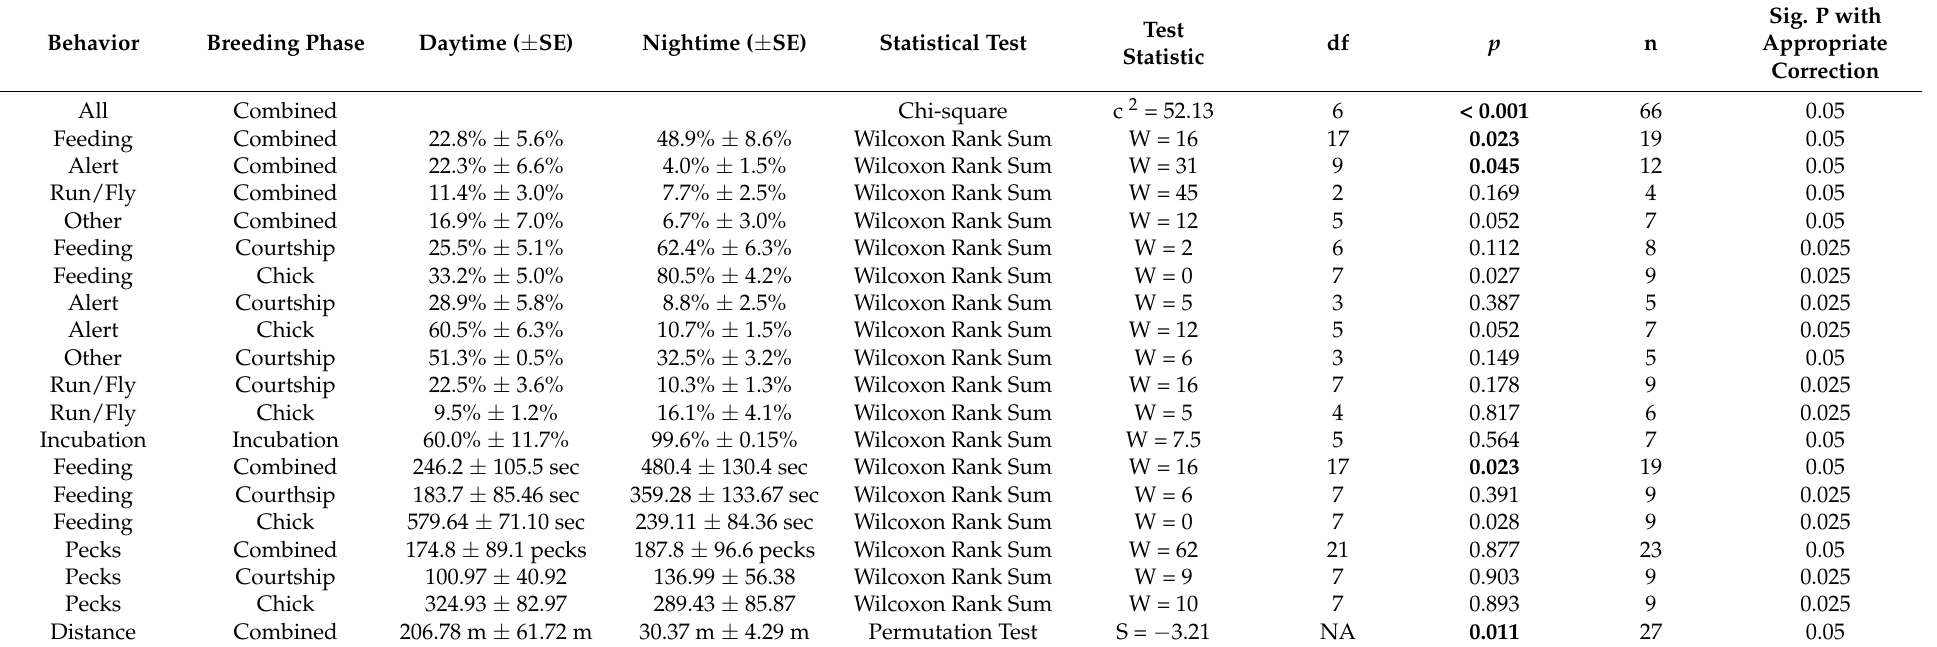
Table 1. Mean ( ± SE), test, test statistic, degrees of freedom, calculated p , sample size ( n ), and correction to p (Bonferroni applied where appropriate resulting in value > 0.05) for all behaviors (combined) and individual behaviors observed, and distance from nest (Distance), of piping plovers nesting along Michigan’s Lake Superior shoreline in